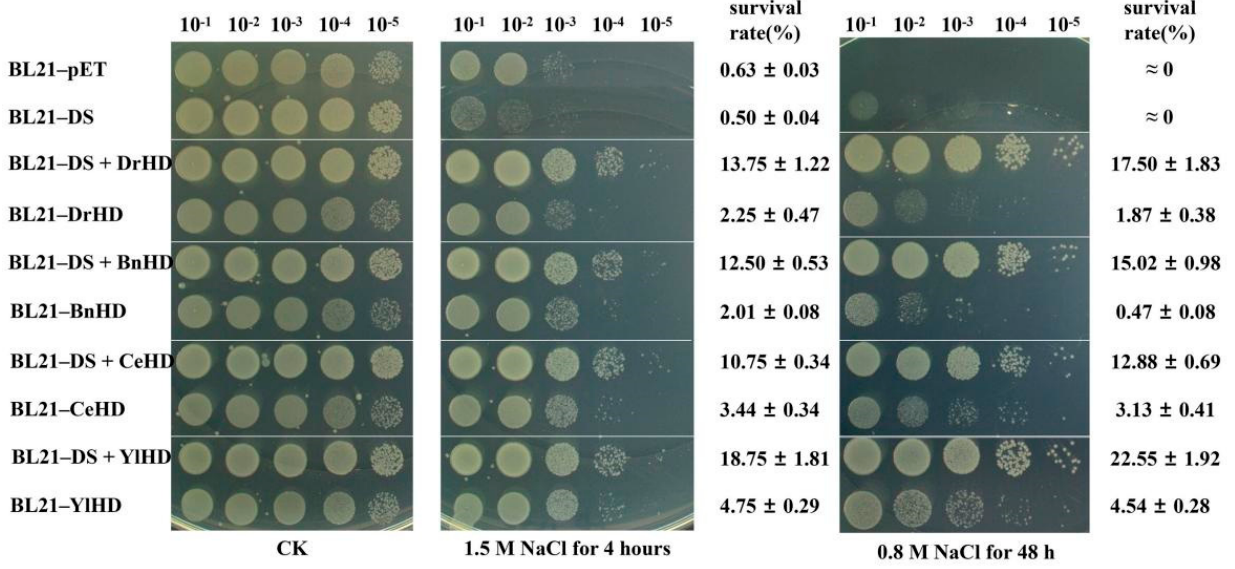
Figure 2. Survival phenotype plate assay of E. coli recombinant strains under high salt condition.